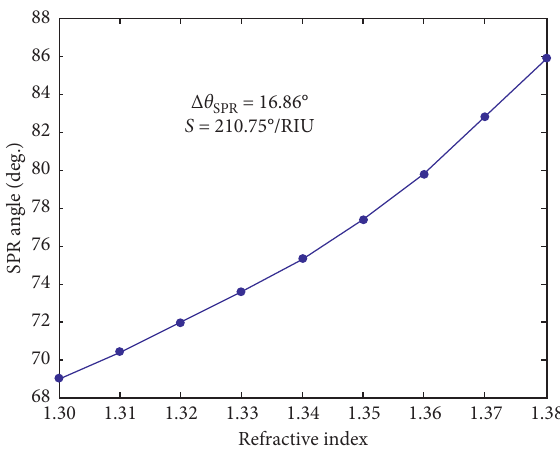
Figure 7: The effect of refractive index n on θ